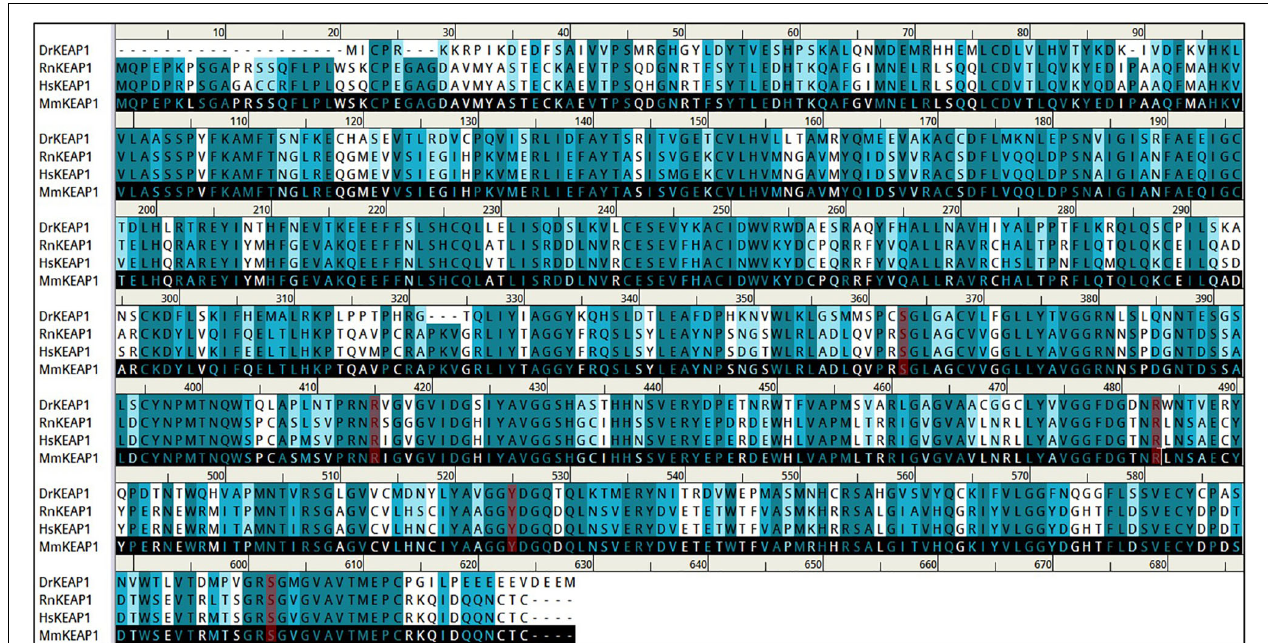
FIGURE 8 | Arg483, Ser363, Arg525, and Ser602 are conserved residues in the Nrf2-binding site of